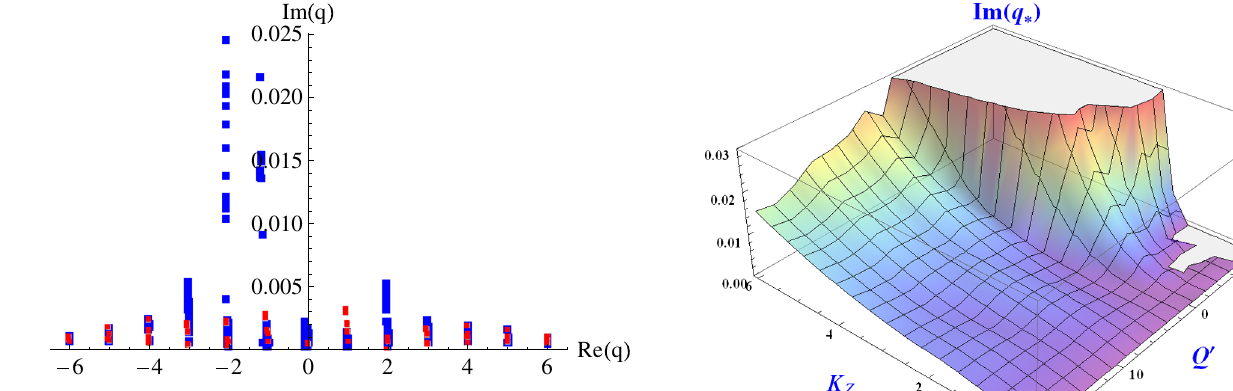
FIG. 6. Horizontal eigenvalues of a standard single beam with the damper gain g ¼ 1 . 4 and chromaticity Q 0 blue dots show the same case with the damper off.